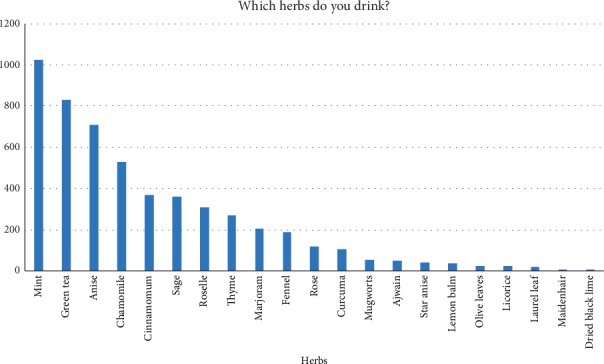
Analyses of the survey question, (which herbs do you drink?).